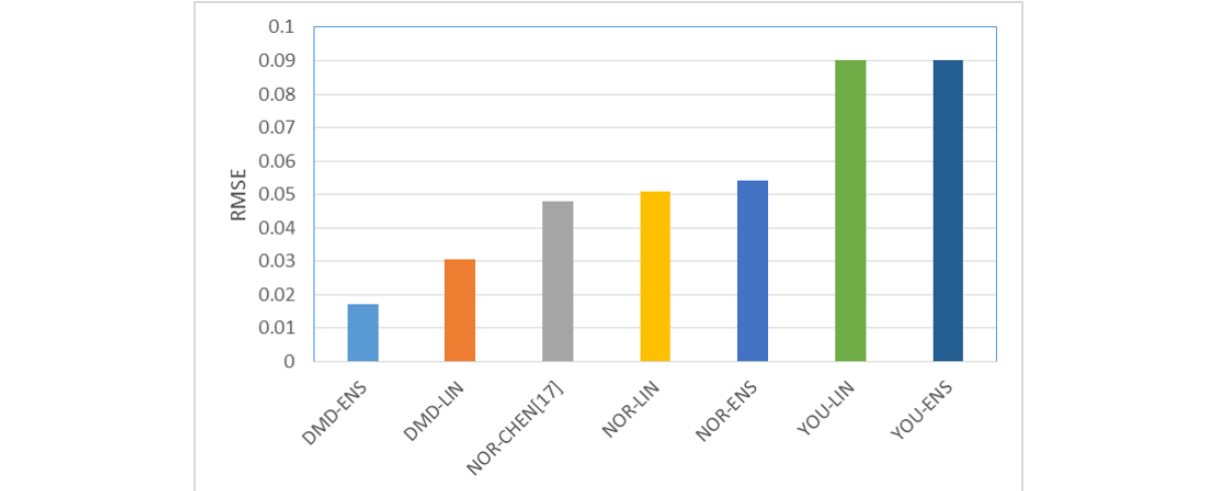
Figure 4. Bar chart showing root mean square error obtained using different